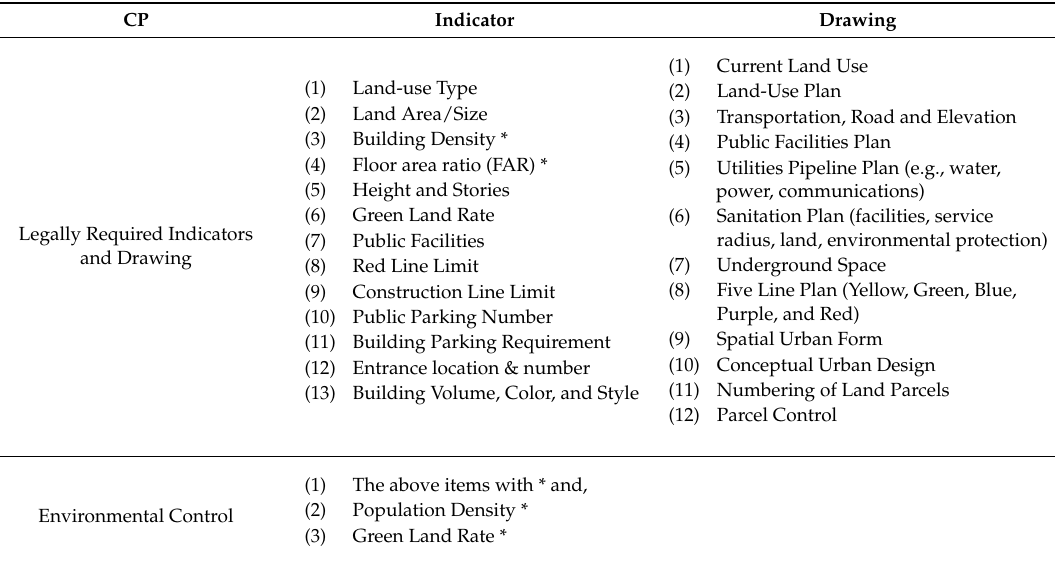
Table 1. Control-Specific Planning (CP) Index System and Drawings.